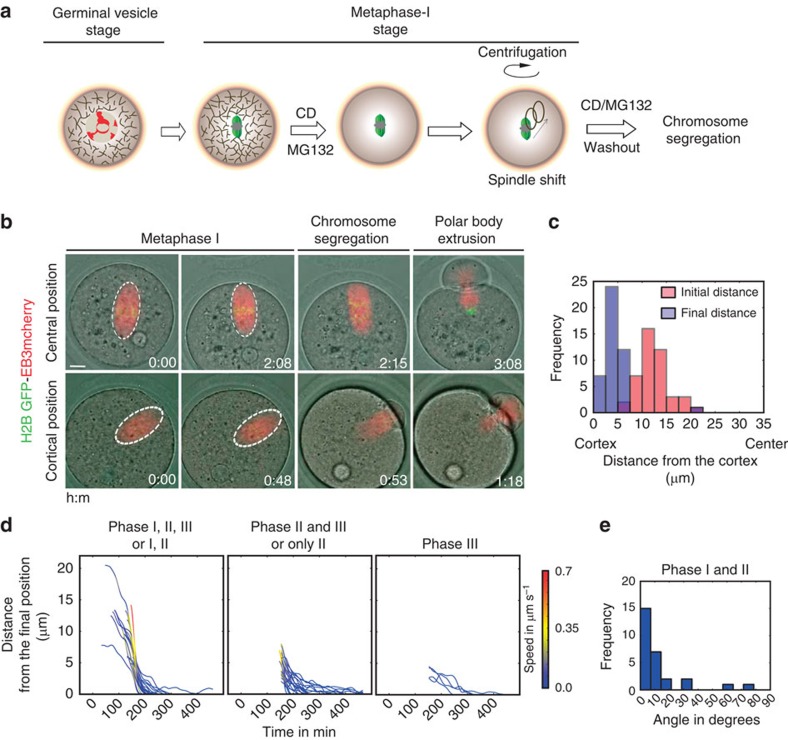
SPC assay III.(a) Schematic representation of the SPC assay III. Two hours after GVBD, the oocytes were transferred into a medium containing 0.5 μg ml−1 of CD. At the expected time of chromosome segregation (7 h after GVBD), oocytes were transferred into medium containing 4 μM MG132 and 0.5 μg ml−1 of CD, centrifuged for 1 h at 1,000 r.p.m. at 37 °C. After the spindle shift, oocytes were immediately removed from CD and MG132 and transferred to the microscope for 4D live-cell imaging (details are shown in Supplementary Fig. 6a). (b) Time-lapse imaging of oocytes expressing EB3-mCherry and H2B-EGFP in the SPC assay III. On the top panel, the spindle was initially localized in the centre and on the bottom panel the spindle was localized close to the cortex. Scale bar, 10 μm. (c) Histogram representing initial (at the drugs washout) and final distance (at anaphase onset) of spindles from the cortex in oocytes after CD/MG132 washout in SPC Assay III (>3 independent experiments, n=43). (d) Quantitative analysis of the spindle displacement in the SPC assay III. (e) Histogram representing the angle deviation of the spindle orientation during the relocation.